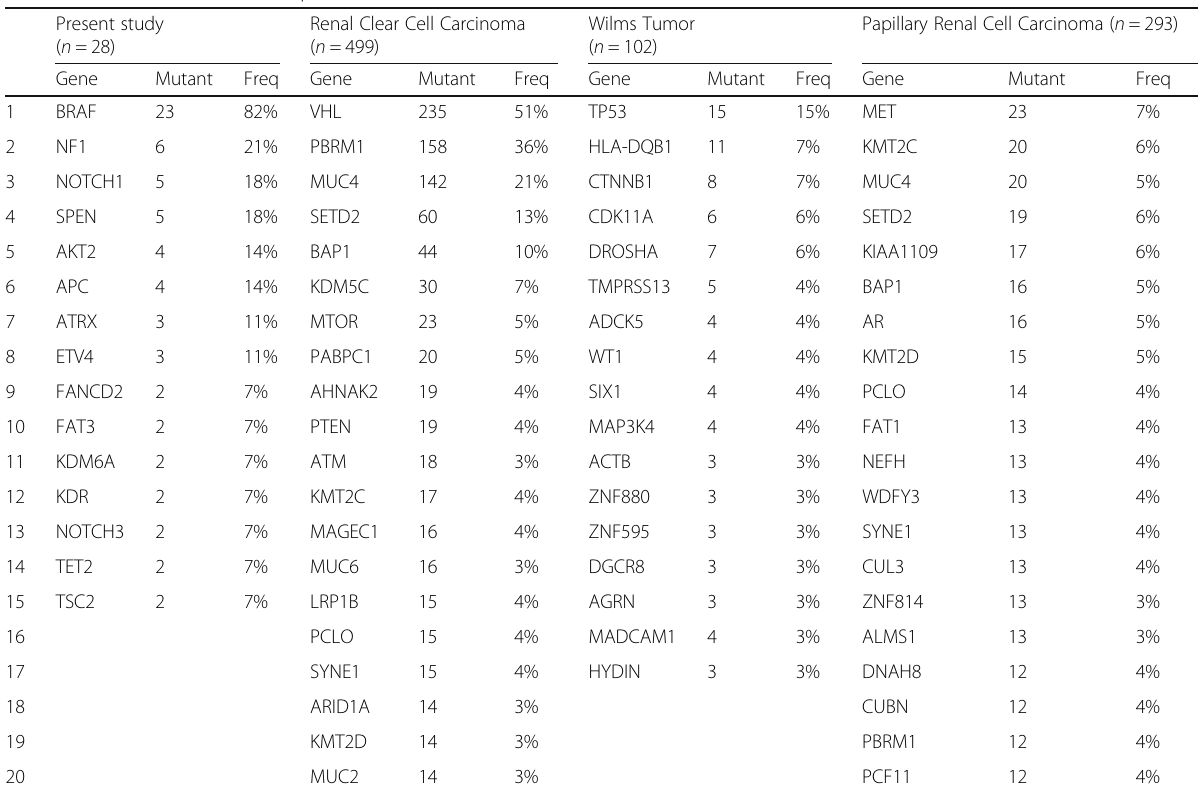
Table 2 The somatic mutation spectrum in different renal carcinoma Present study ( n =